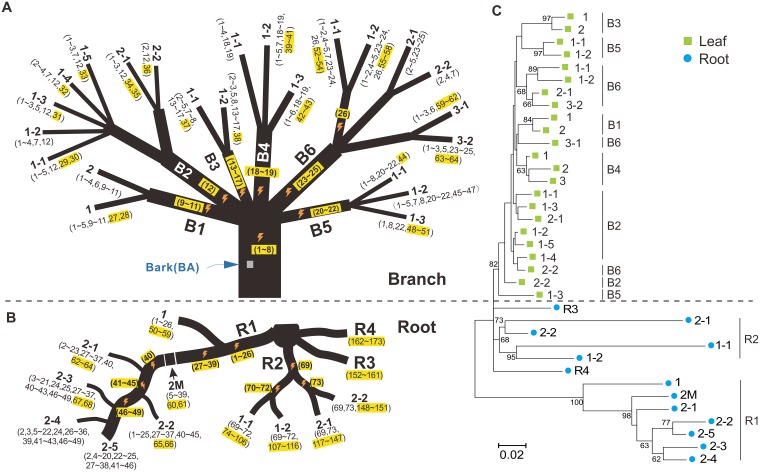
Pattern of somatic mutations in the branch leaves and roots of the peach tree PXL.(A) Somatic mutations identified in leaves. Each mutation is represented by a number (e.g., 1, 2, etc.) in parentheses. The first ontogenetic presence of a mutation is highlighted in yellow. In some instances, a mutation is unique to a terminal branch. If not, the orange lightning symbol represents the putative ontogenetic position of a mutation based on the shared pattern of this mutation. All branch dimensions are not scaled to the real size. (B) Somatic mutations identified in roots. (C) Ontogenetic trees constructed using all mutations identified in both branches (green) and roots (blue). Only bootstrap values over 50% are shown (neighbor-joining method with 1,000 replicates bootstrap test).